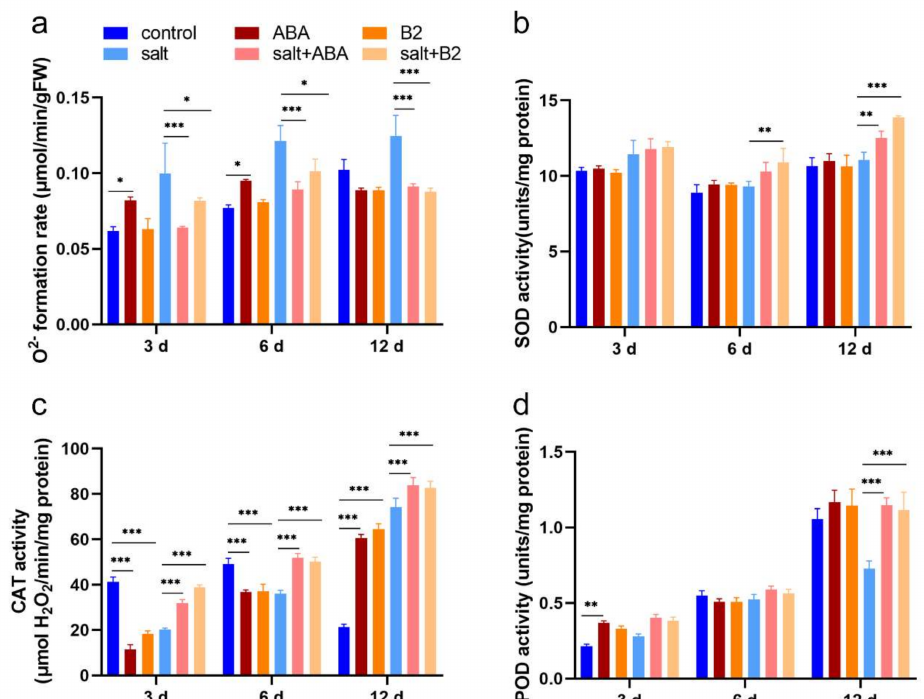
Figure 8. Formation rate of O 2 − and activity of three major enzymes in the antioxidant system in the maize leaves. ( a ) O 2 − formation rate, ( b ) SOD activity, ( c ) CAT activity, ( d ) POD activity. The concentration of B2 was 1.0 µ M, and ABA concentration was 100 µ M. Values were significantly